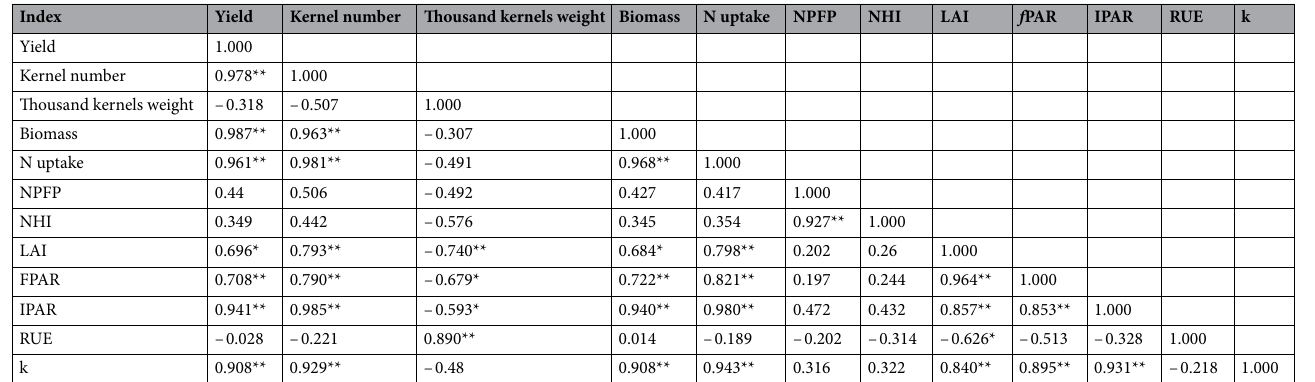
Table 4. Correlation coefficients among maize yield, kernel number, thousand kernels weight, biomass, N uptake, N partial factor productivity (NPFP), N harvest index (NHI), leaf area index (LAI), mean fraction of PAR intercepted ( f PAR), cumulative intercepted PAR (IPAR) and radiation use efficiency (RUE) for different planting treatments in 2017 and 2018. n = 12, R 0.05 = 0.576, R 0.01 = 0.707. *Significance of correlation at 0.05 level. **Significance of correlation at 0.01 level.